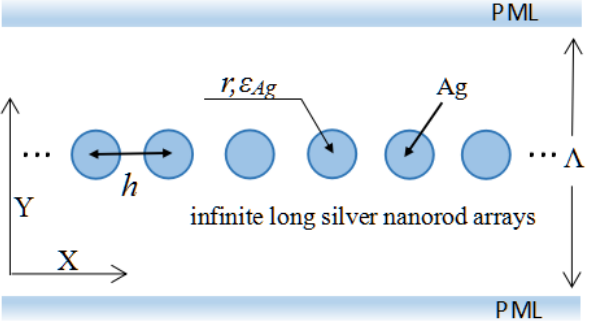
Figure 1. Infinite periodic chain of circular rods along the x-axis with lattice constant h . Radius and dielectric permittivity of rods are r and ε , respectively.